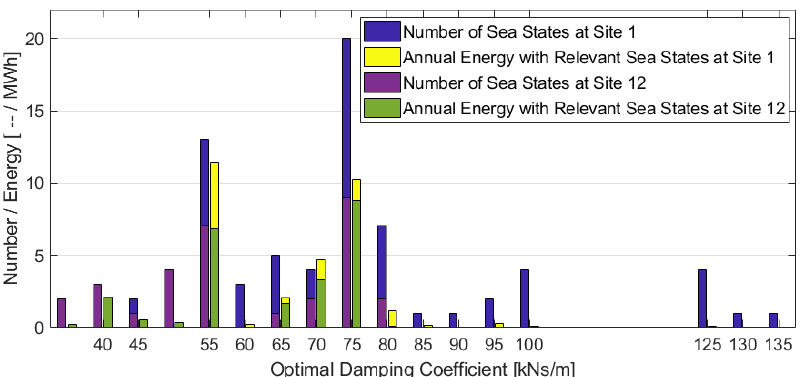
Figure 15. Comparison of the contribution of each optimal damping coefficient to overall annual energy: blue and violet stacks show the number of sea states at Site 1 and Site 12, respectively; the yellow and green stack represent Site 1 and Site 12, respectively; these bars represent the total energy for the corresponding optimal damping coefficient.